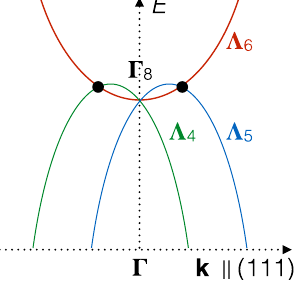
FIG. 7. Schematic band structure of unstrained HgTe near Γ